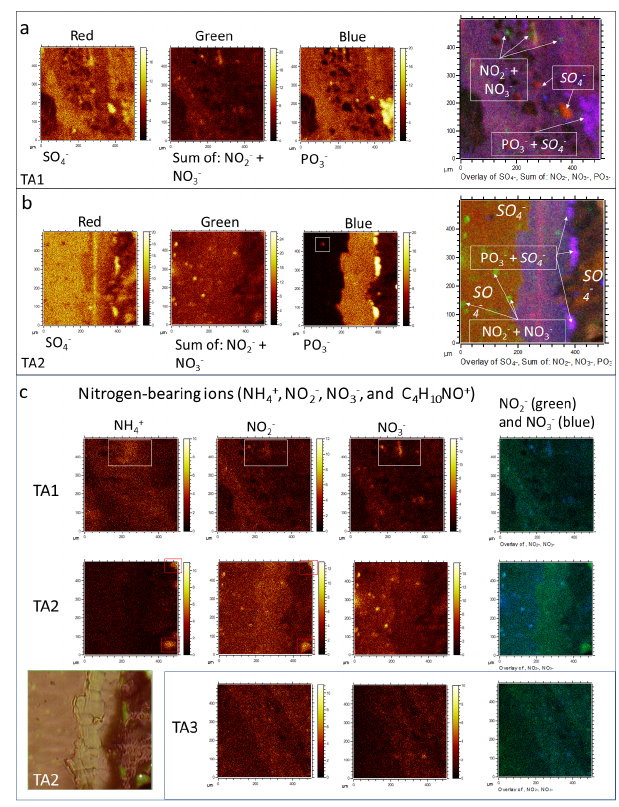
Figure 4. Distribution of main anions like SO 4 − , NO 2 − + NO 3 − , and PO 3 − with potential biological origin in TA1 ( a ) and TA2 ( b ). The NO − n(2 ≤ n ≤ 3) ions occur forming <20 micron-sized nodular structures inside the ferric microlaminated ( a ) and the glassy ( b ) layers. N-bearing anions are also found forming a few larger (<40 microns) nodular structures ( b ) inside the silica-rich unit. Furthermore, PO − n(2 ≤ n ≤ 4) appear as patches ( a ) or discontinuous laminas ( b ) limiting two different layer units. Phosphate also occurs forming micronodular structures (<20 microns) inside the microlaminar layer. An isolated phosphate-rich micronodule ( b ) is also found in the glassy layer (white square). ( c ) Shows a composition of ToF-SIMS images displaying the distribution of the different N-bearing ions like NH 4+ , NO 2 − , and NO 3 − in target areas TA1, TA2 and TA3. The ToF-SIMS images were obtained from a rasterized surface area of a 500 μ m square.